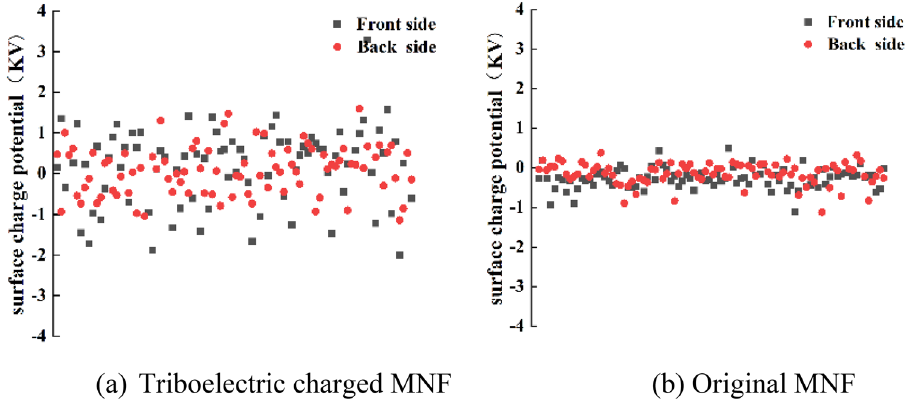
Figure 5. Surface charge potential of MNF before and after triboelectric charging treatment.